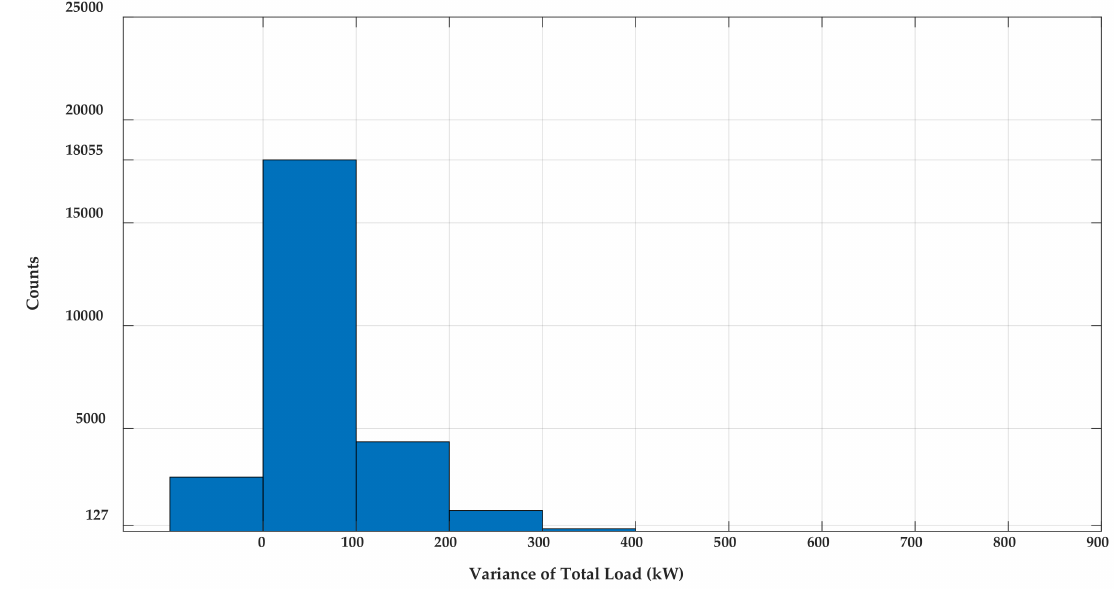
Figure 7. Ten-minute variation histogram.